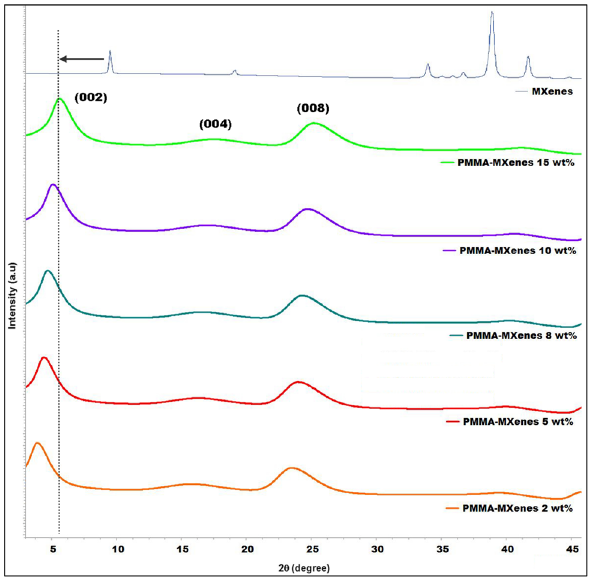
Figure 4: XRD patterns of as - prepared MXenes and PMMA – MXenes